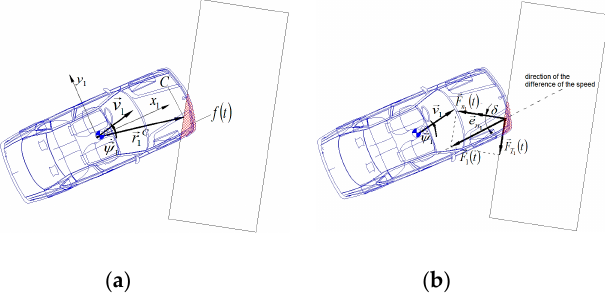
Figure 6. Diagram depicting the calculation method for an impact with a rigid barrier ( a ) and momentary force of impact with a rigid barrier ( b ).